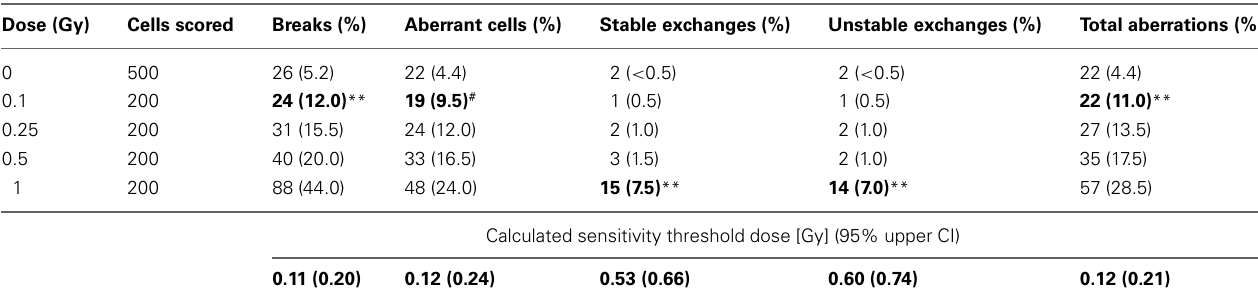
Table 1 | Results of m-FISH analysis in irradiated AG01522 fibroblasts: scores and relative frequencies. Dose (Gy) Cells scored Breaks